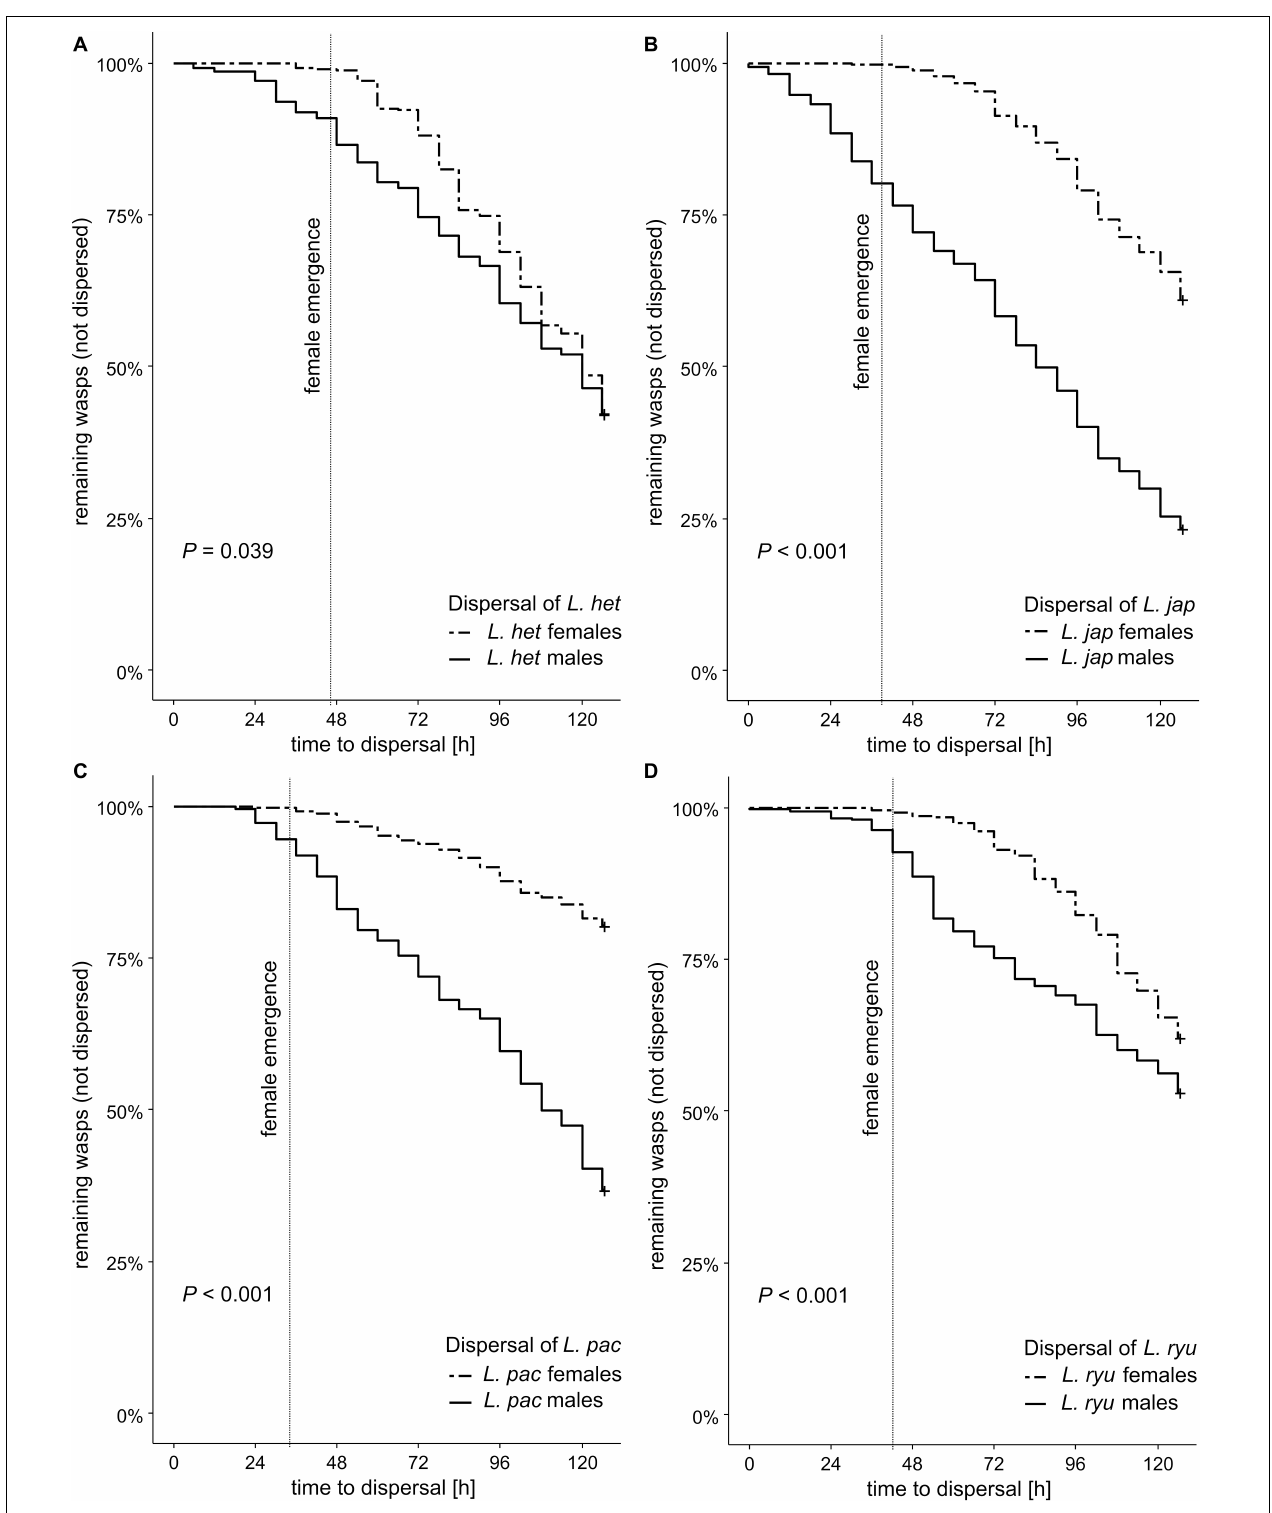
FIGURE 1 | Kaplan Meier plots showing the probability of dispersing for female and male wasps of (A) L. heterotoma ( L. het ), (B) L. japonica ( L. jap ), (C) L. pacifica ( L. pac ), and (D) L. ryukyuensis ( L. ryu ) within the first 126 h after emergence of the first wasp per jar. Numbers of females and males were summed up over all jars. The mean time point of female emergence per species is indicated with a dotted vertical line. Statistical differences between dispersal curves of the different sexes were analyzed with log rank tests. For each experiment, N = 30.